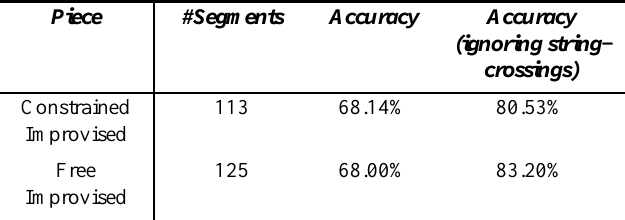
Table 6: Performance on the Improvised Pieces for Subject 3